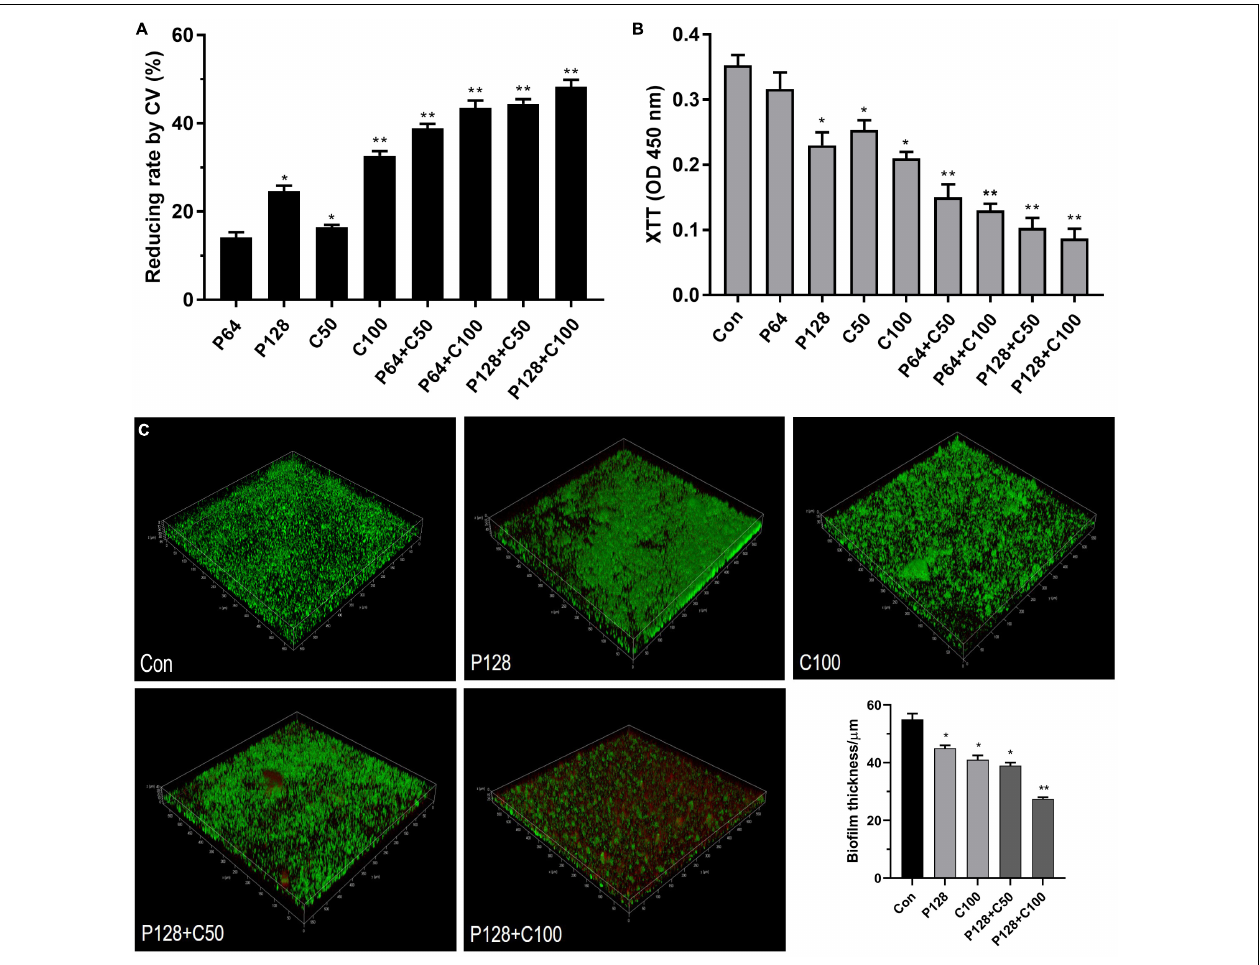
FIGURE 5 | Eradication of ε -PLH combined with CEO on the performed dual-biofilms of L. monocytogenes and P. lundensis . (A) Biofilm removal measured by CV biomass, (B) biofilm inactivation measured by metabolic activity, and (C) CLSM images. Data were expressed as mean ± standard deviations ( n = 3). * p < 0.05; ** p < 0.01: significant interspecies